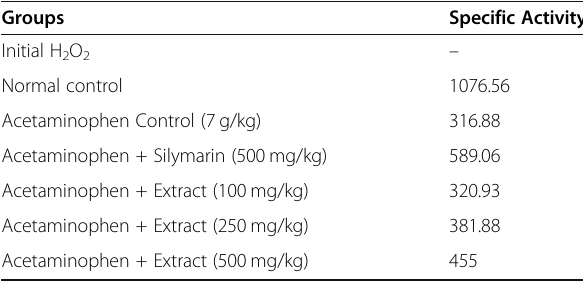
Table 7 Effect of ethanol fruit extract of F. benghalensis on the activity of the antioxidant enzyme (Catalase) in goat liver after Acetaminophen administration Groups